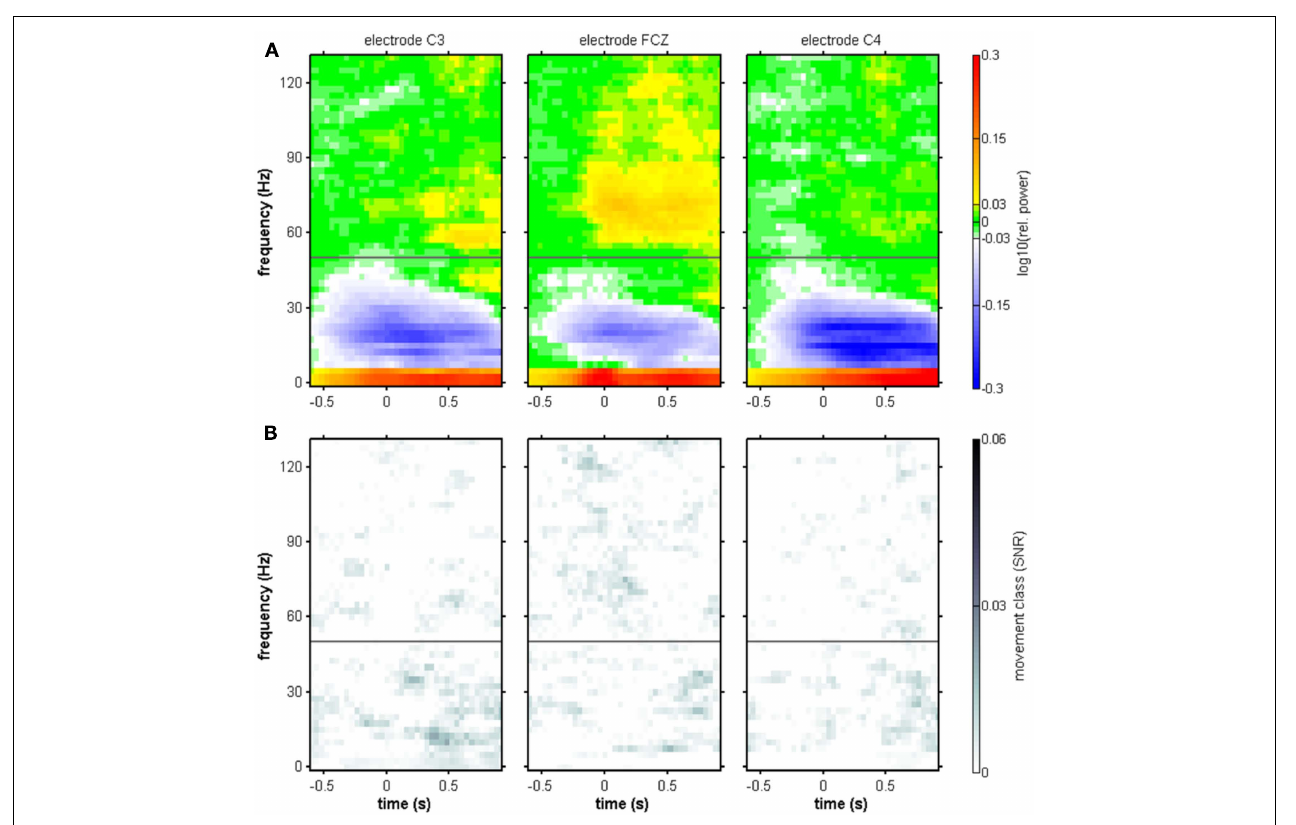
FIGURE 4 | Movement onset-aligned group-averaged spectral power changes and SNR of movement class tuning. Electrode positions C3, FCZ, and C4. (A) Median relative spectral power changes across subjects. As in the individual results in Figure 3 , power increases in low ( ≤ 5Hz) and high- γ